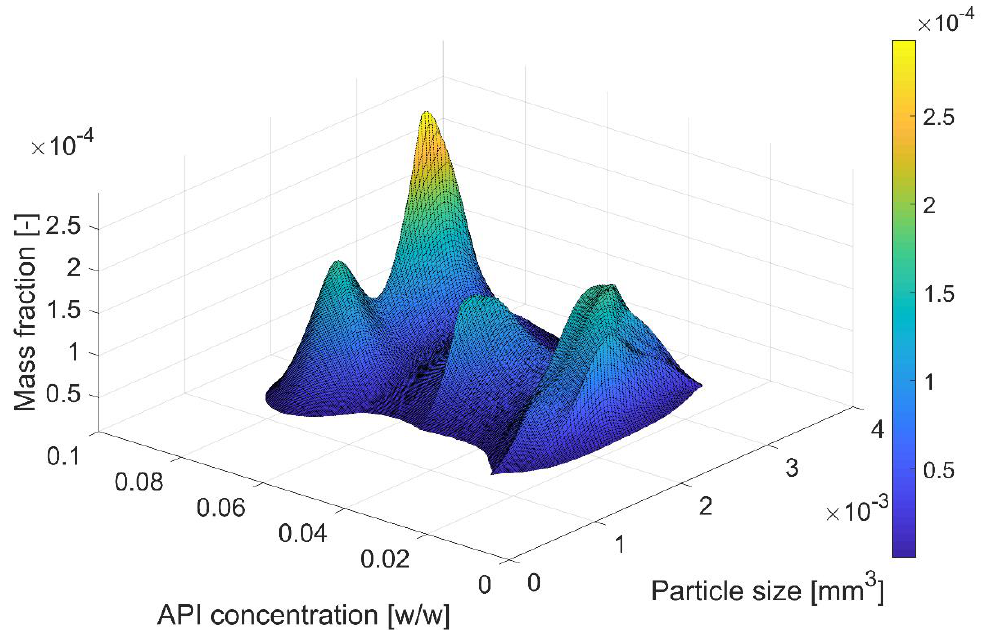
Figure 14. Distribution of the material in the product at steady-state.